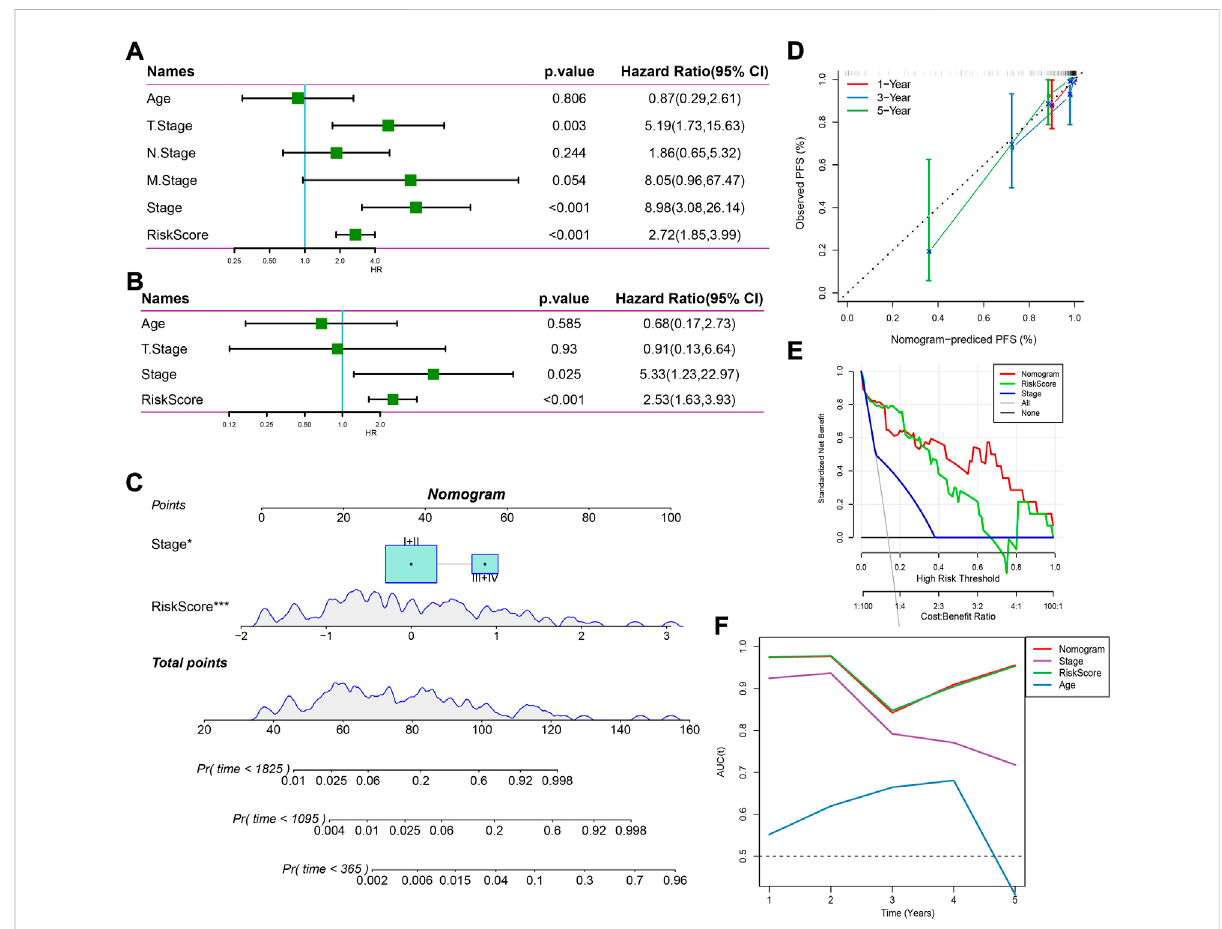
FIGURE 6 Establishing a nomogram based on the risk score. (A,B) Univariate (A) and multivariate (B) Cox regression analysis on age, stage, and risk score. (C) Anomogramforpredictingdeathratebasedonriskscoreandstage. (D) Calibrationcurveof1-,3-,and5-yearOS. (E) Decisioncurveofstage,risk score, and nomogram. (F) AUC of age, stage, risk score, and